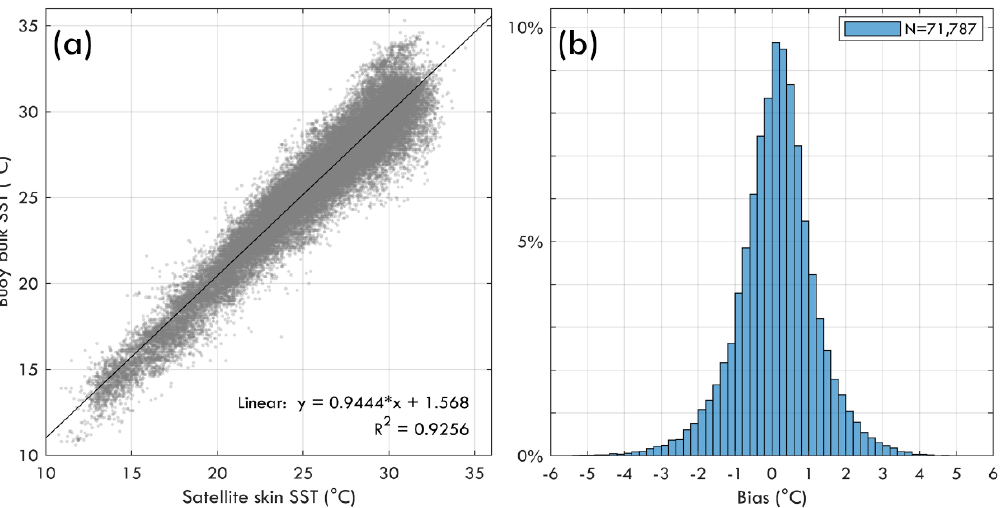
Figure 11. (a) Comparison of SST data between buoys and the Himawari-8 satellite and (b) the his- togram of bias for bulk-skin SST data pairs (b) for all samples. Figure 11. ( a ) Comparison of SST data between buoys and the Himawari-8 satellite and ( b ) the histogram of bias for bulk-skin SST data pairs ( b ) for all